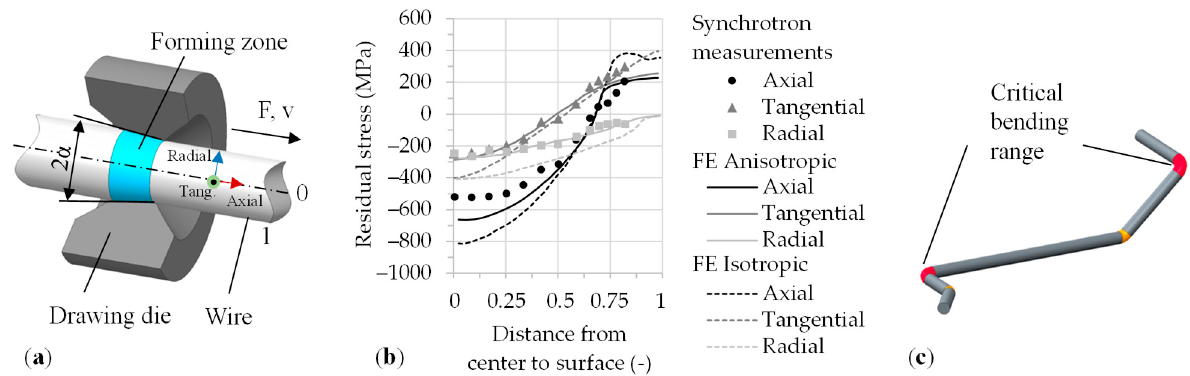
Figure 1. ( a ) Wire-drawing tool, ( b ) residual stress distribution to Adapted with permission from ref. [8], and ( c ) critical areas on a torsion bar